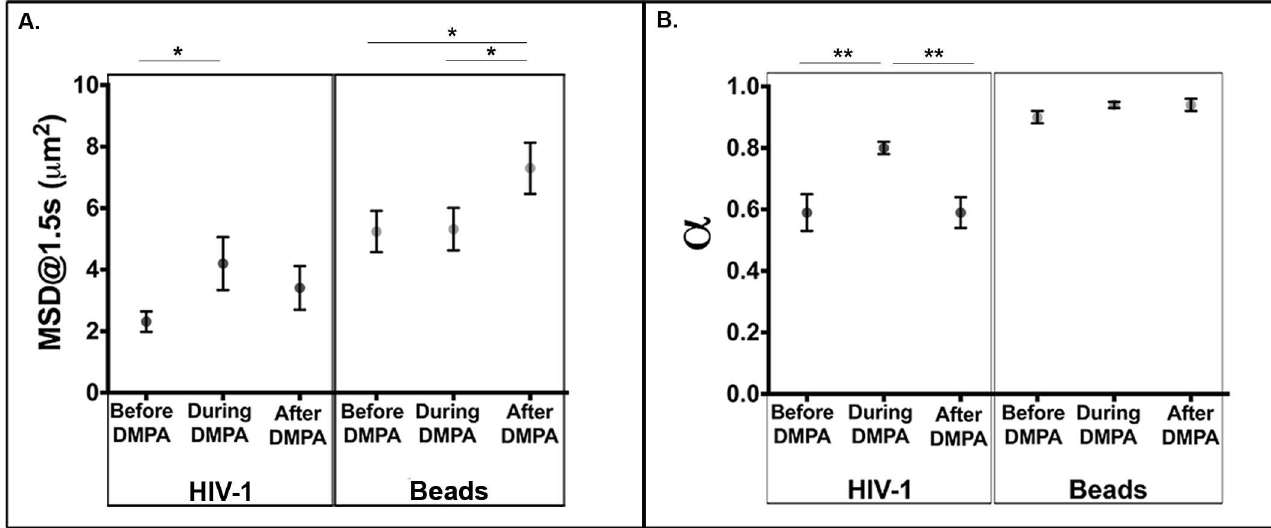
Fig 3. HIV-1 and 200nmbead diffusion in pigtailmacaque mucus before,duringand afteradministration of DMPA. Estimatedmeans and standarderrorswere calculatedfor (a).Mean-squared displacement (MSD)values for all particletypes in each mucus samplecollectedbefore (n = 29), during(n = 16) and after(n = 34) DMPA administration.(b).Alpha ( α )values for all particletypes in each mucus samplecollectedbefore (n = 29), during(n = 16) and after(n = 34) DMPA administration.For each treatmentcondition,generalized linearmixed modelswere runto compare estimatedmeans for particleMSD and α